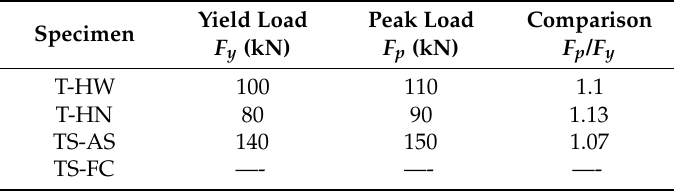
Table 3. Load carrying capacity of specimens.